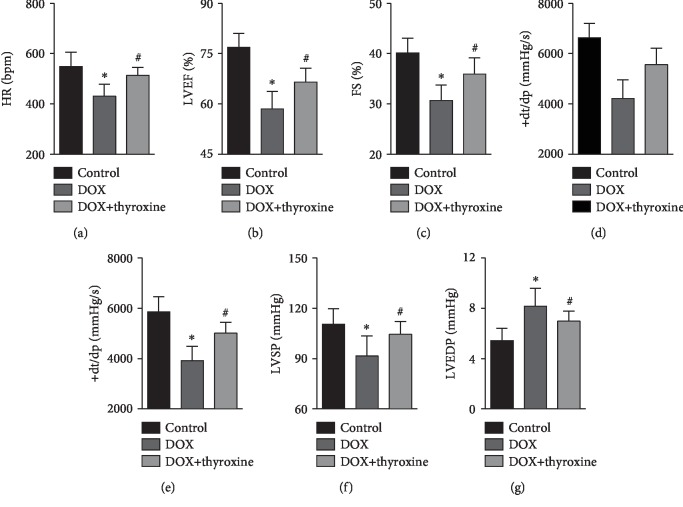
Left ventricular function was measured by echocardiography and analysis of hemodynamic data in mice treated with PBS or thyroxine (1.25 mg/kg) after administration of saline or DOX (15 mg/kg) for 5 days. (a–c) HR, LVEF, and FS were evaluated in the three groups by echocardiography. (d–g) Positive and negative dP/dt max, LVSP, and LVEDP were assessed in each group based on hemodynamic data. N = 12 in each group. ∗P < 0.05 vs. control group; #P < 0.01 vs. DOX group.